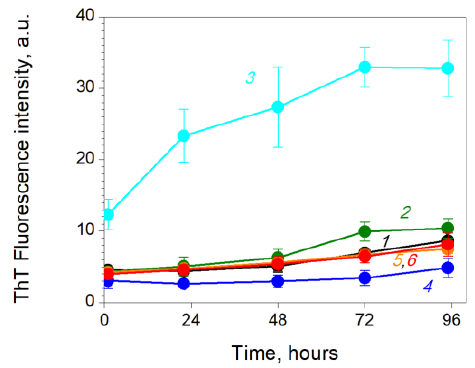
Figure 4. Seeding of native PrP solution with PrP fibrils (curve 1 , black) and the complexes formed in the same conditions in the presence of the polyanions: DS-100kDa ( 2 ), PSS-155 ( 3 ), PSS-1700 ( 4 ), PAS ( 5 ), and PVS ( 6 ). MOPS 20 mM, pH 7.5. Values averaged over independent samples ± SD are shown.